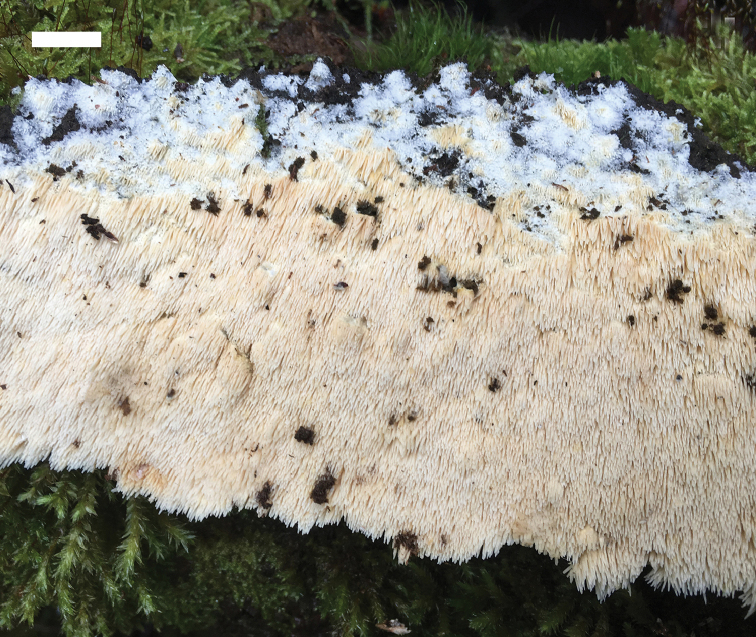
A fresh basidiocarp of Dentipellistasmanica (holotype). Scale bar: 1 cm.